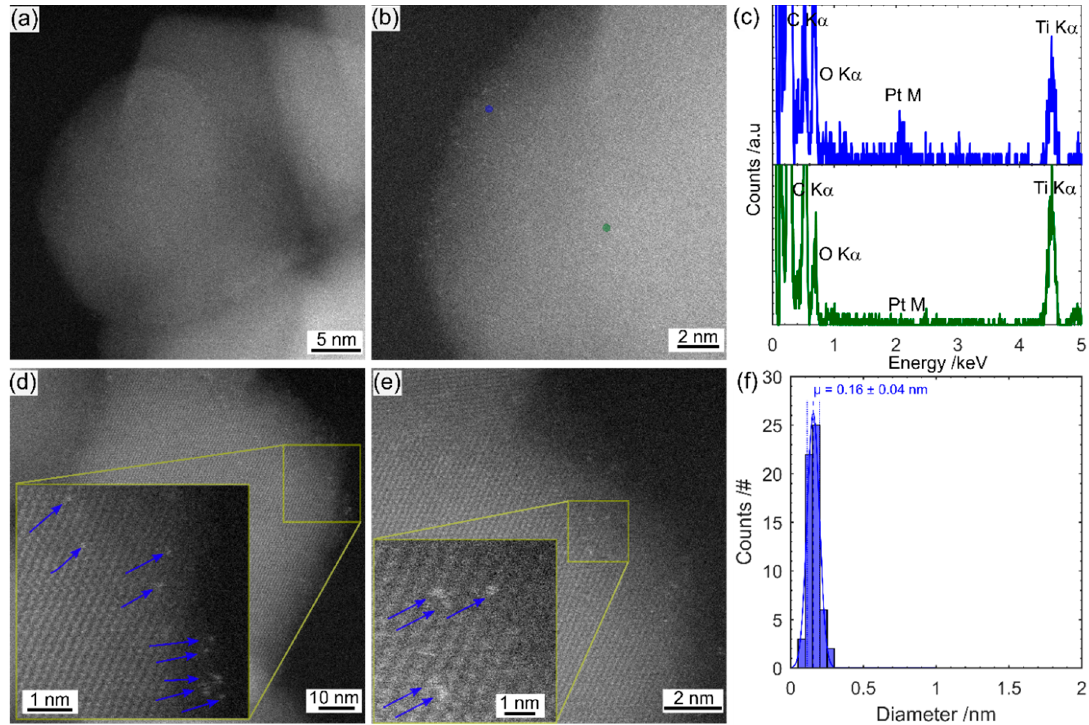
Figure 3. TEM images ( a , b , d , e ), EDS plots ( c ) and particle size histogram ( f ) for P25-Pt-nc samples produced via Pt impregnation. The EDS plots ( c ) are from points highlighted in ( b ) with green and blue circle corresponding to the green (TiO 2 only) and red (Pt nc on TiO 2 ) EDS spectra. Pt nc diameter distribution ( f ) with normal distribution analysis obtained from >5 images an 58 measured nanoparticles. Arrows in the inset of ( d , e ) highlight single Pt atoms.